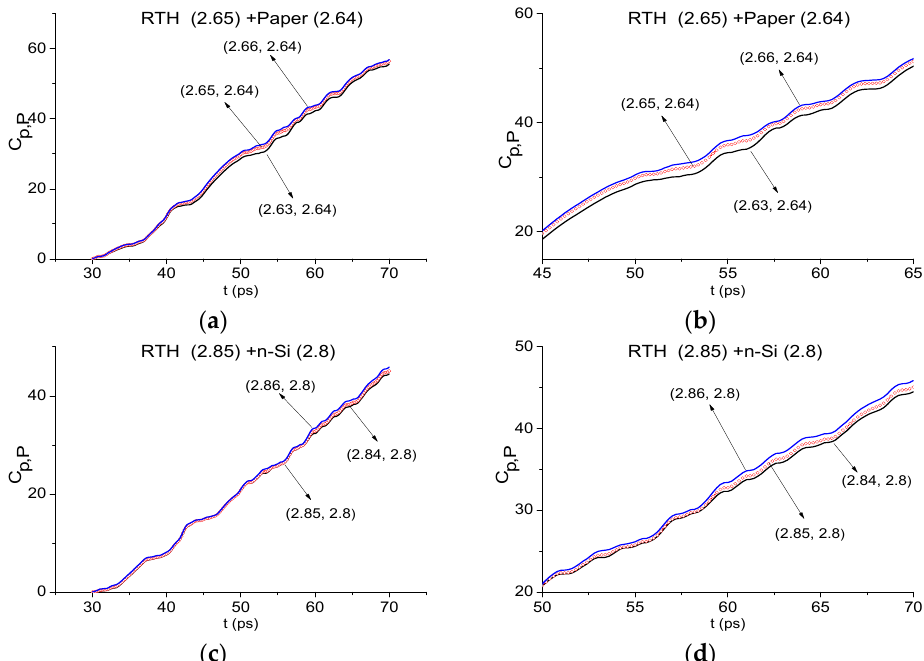
Figure 26. ICC C p , P computed for the frequencies ν = 2.65 THz ( a,b ) and 2.85 THz ( c,d ) in the time intervals t = [30, 70] ps ( a,c ), [45, 65] ps ( b ) and [50, 70] ( d ) with paper ( a,b ) and n-Si ( c,d ) standard signals.